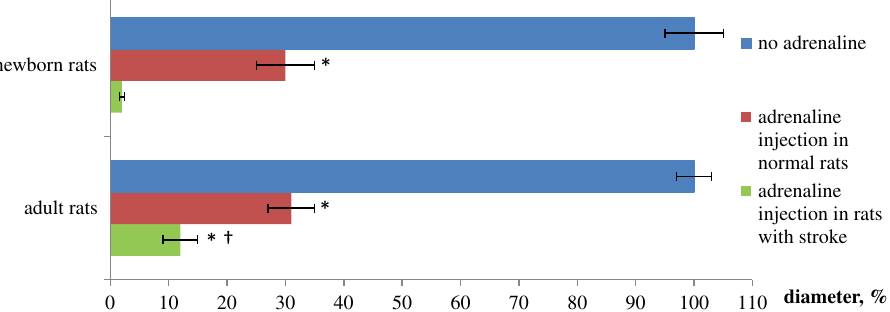
Fig. 4. The changes in diameter of the sagittal sinus (%) after adrenaline injection in newborn and adult rats under normal state and during stroke development. The basal values of diameter of sagittal sinus (no adrenaline) were expressed as 100%.